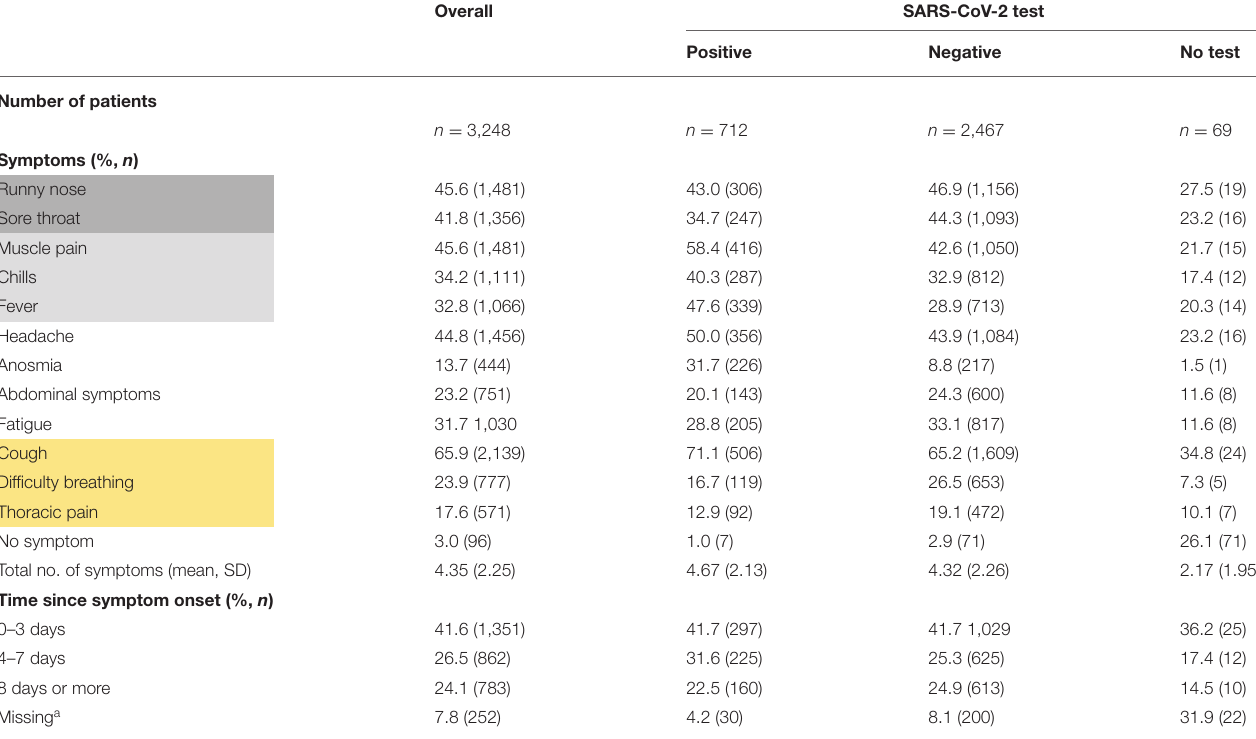
TABLE 2 | Description of symptoms.